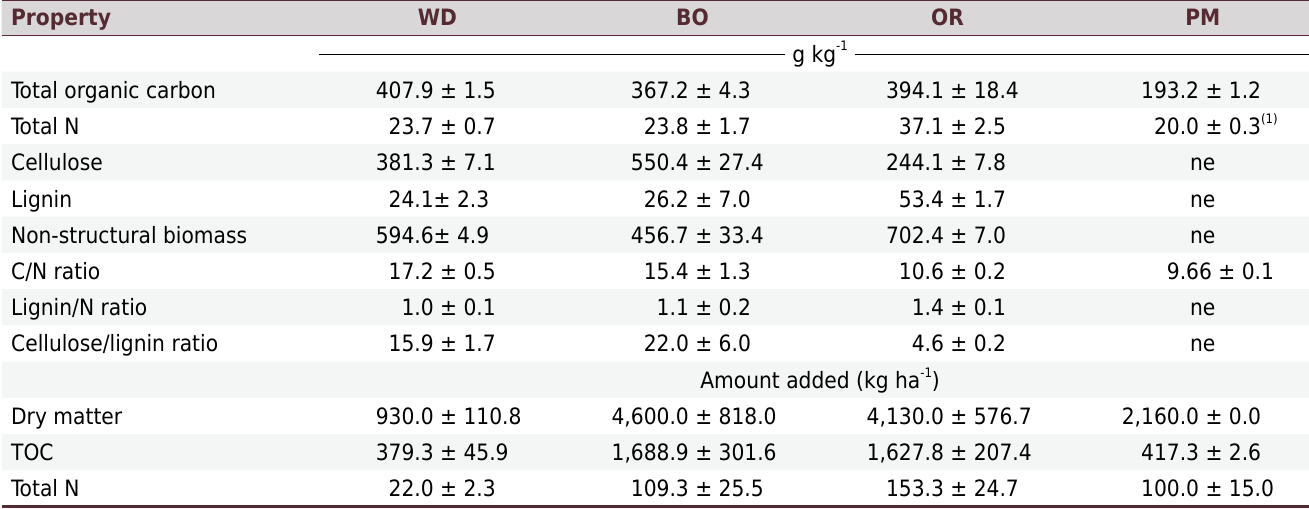
Table 2. Chemical properties of the residues of weeds (WD), black oats (BO), oilseed radishes (OR), and poultry manure (PM) used in the field and laboratory studies